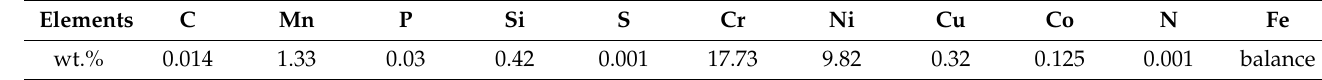
Table 1. Chemical composition of 304L stainless steel measured by